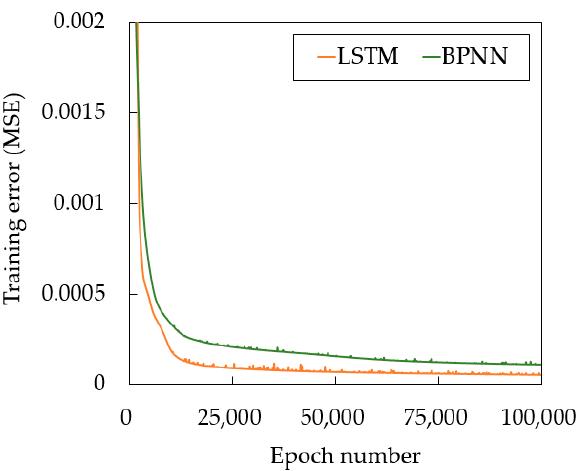
Figure 9. Training curve comparison between the proposed LSTM and BPNN models.